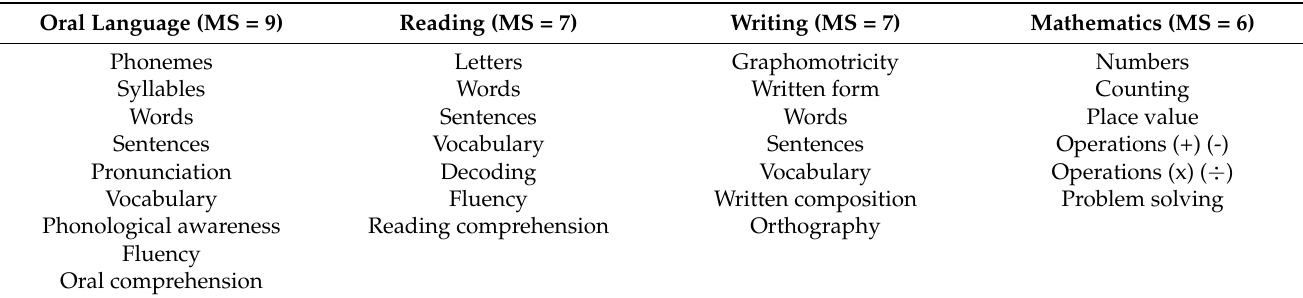
Table 1. Sub-areas of basic instrumental skills